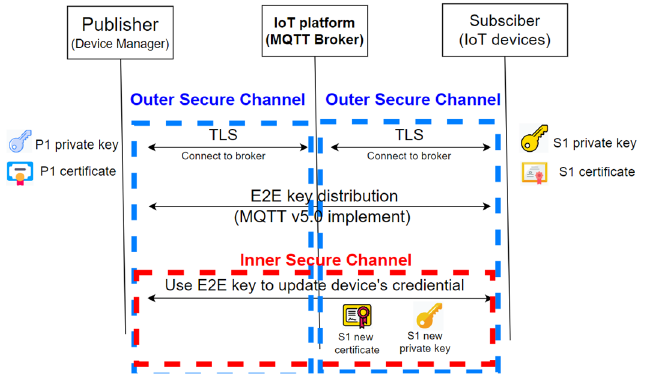
Figure 4. The two channels of the OTA